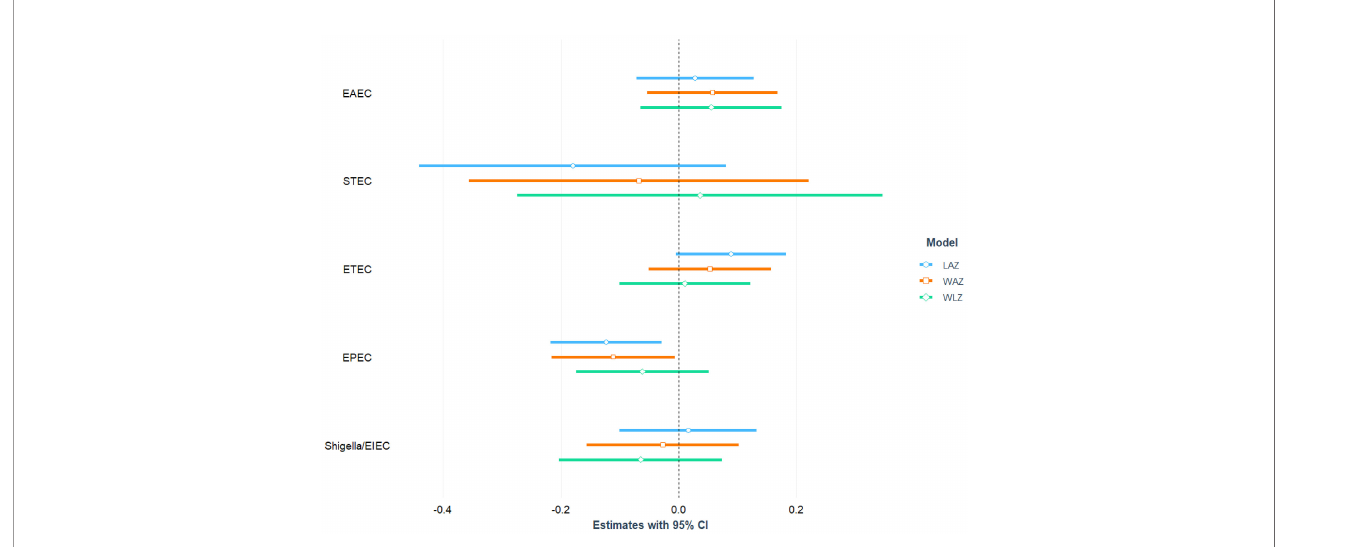
FIGURE 3 | Association between E. coli pathotypes and nutritional status of